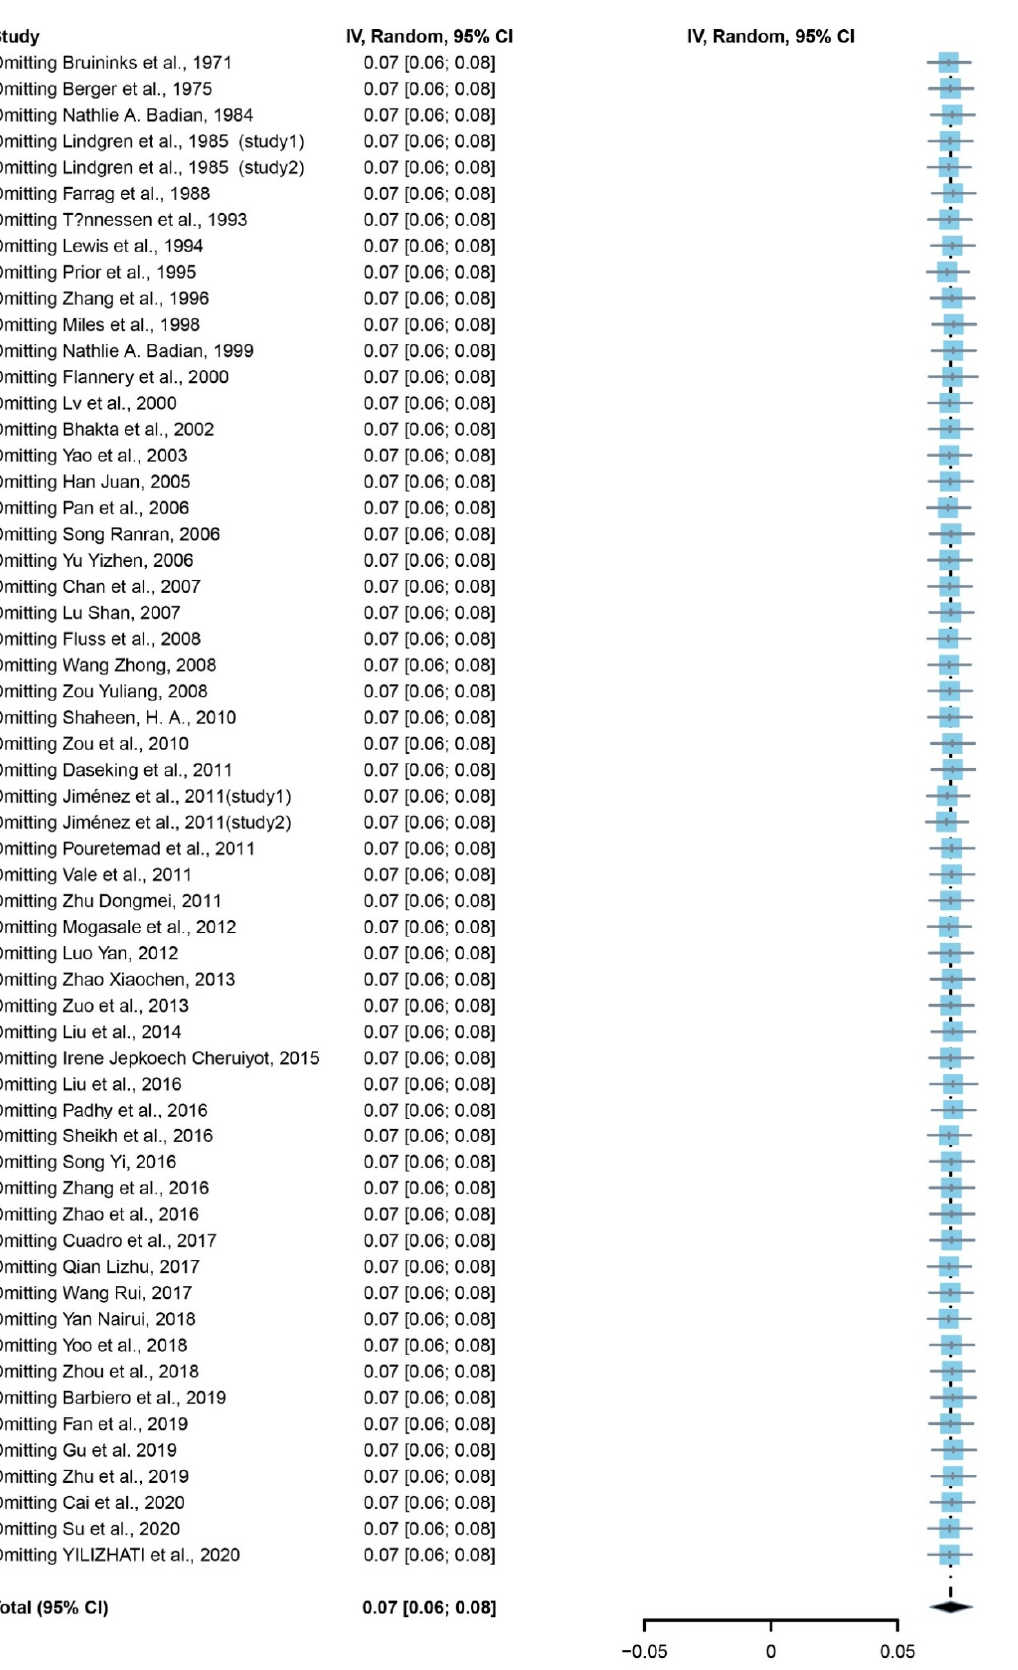
Figure A1. Leave-1-out forest.